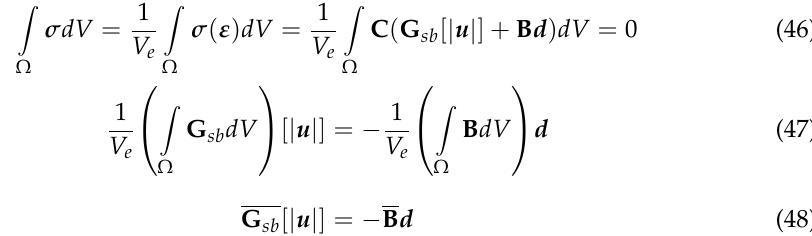
Figure 8. Generation of strain sub-spaces coming from d and [ fracture kinematics only represented through rigid body translations is not able to cover the subspace spanned by the nodal standard displacement